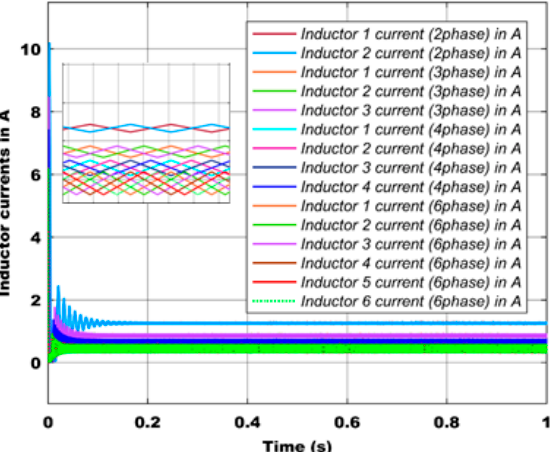
Figure 5. All phases inductor current comparison of MPIBC at duty cycle of 50%.